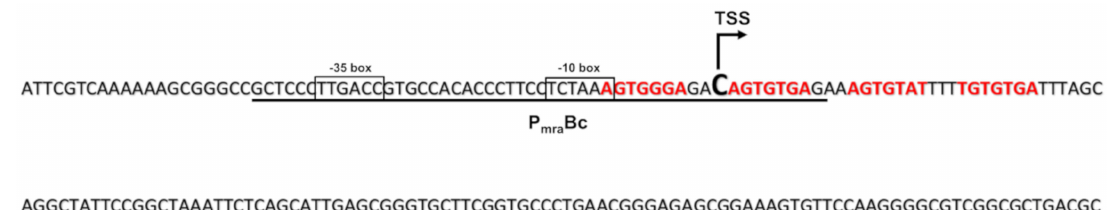
Figure 2. Organization of the P mra Bc promoter sequence. The promoter sequence (P mra Bc) is underlined in bold, with the − 10 and − 35 boxes, the cytosine representing the transcription start site (TSS) of the dcw operon, and the repeats of the putative MraZ binding site highlighted in